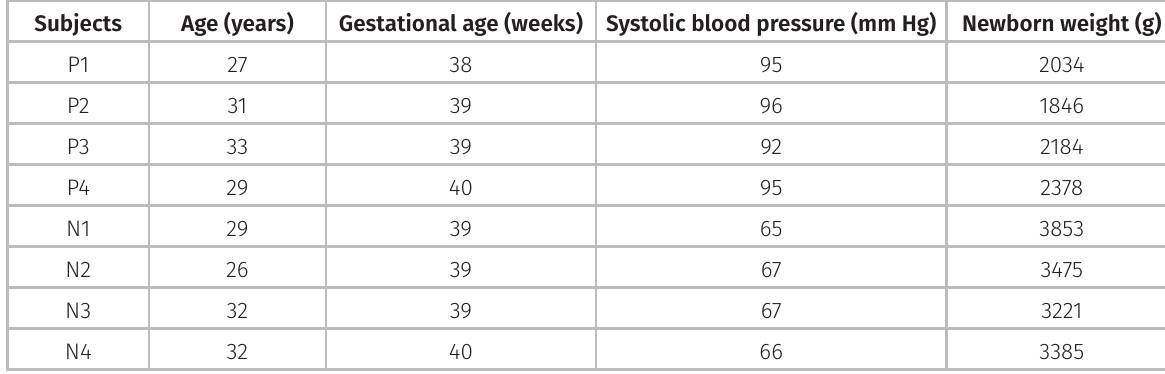
P indicates pregnant women with preeclampsia; N indicates normal pregnant